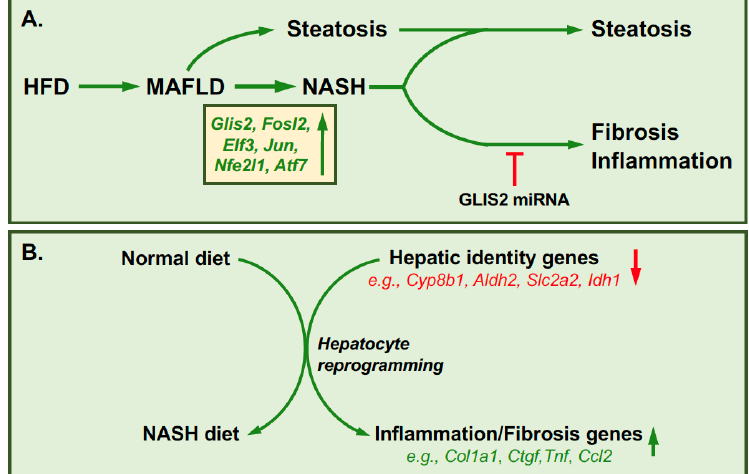
Figure 4. Role of GLIS2 in hepatocyte reprogramming during non-alcoholic steatohepatitis (NASH). ( A ) Diet-induced MAFLD can progress to the development of NASH. This is accompanied by increased expression of several transcription factors, including GLIS2, FOSL2, JUN, ATF7, NFE2L1, and ELF3, that together regulate the induction of inflammatory and fibrotic genes [41]. Down-regulation of GLIS2 by Glis2-miRNA inhibits inflammation and fibrosis but has no effect on steatosis (lipid accumulation). ( B ) Hepatocyte reprogramming during NASH. Hepatocyte identity genes are downregulated, whereas genes involved in fibrosis and inflammation are induced during NASH.